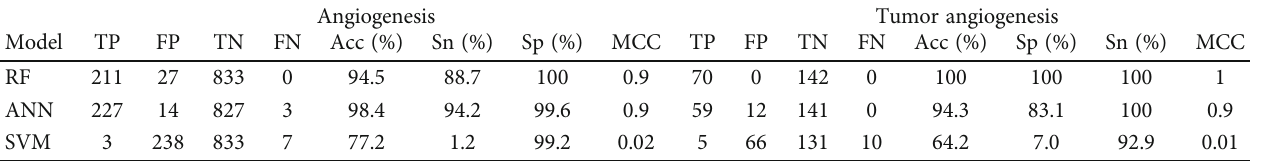
Table 5: Independent set results.